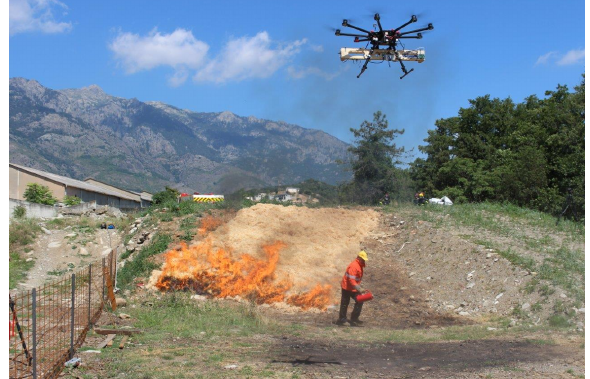
Figure 25. Configuration of the fire test